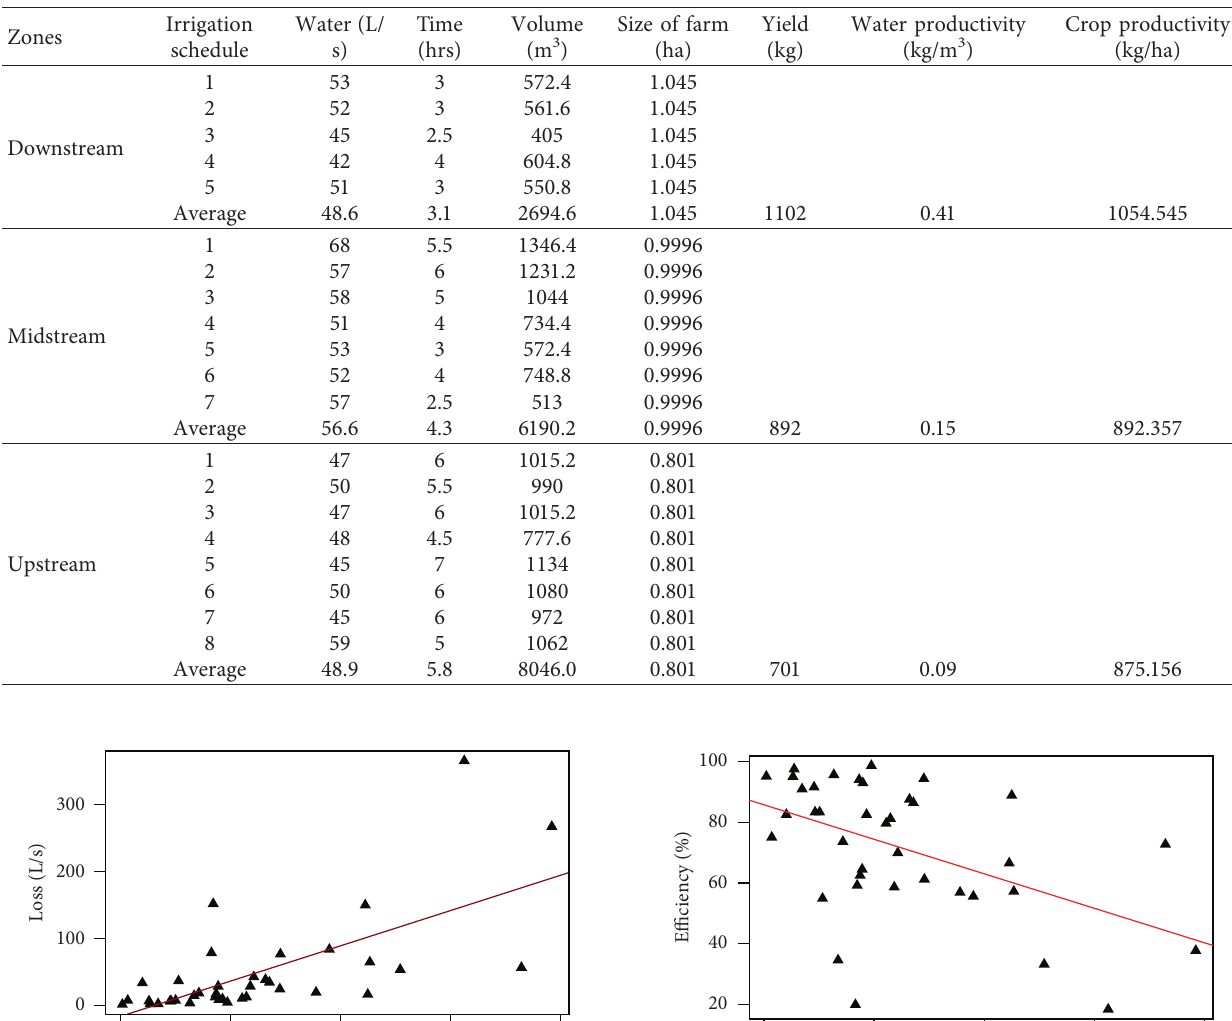
Table 3: Irrigation schedule, hours, water quantity, farm size, and crop water productivity.